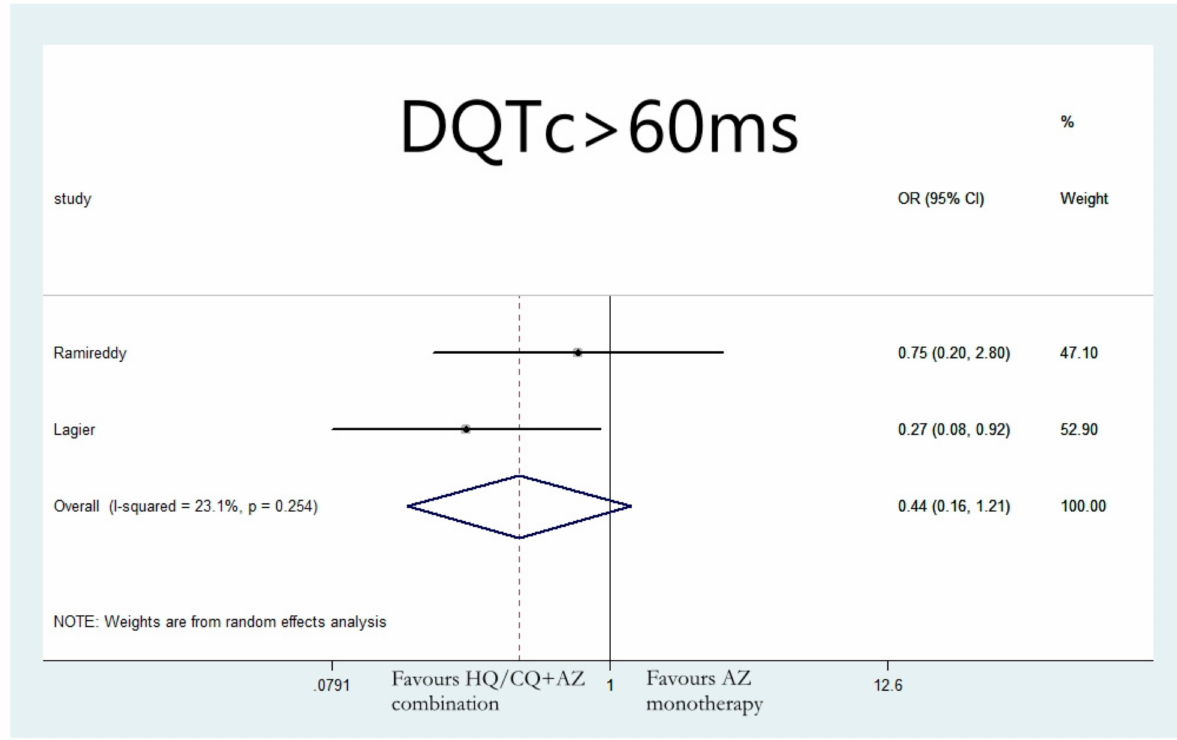
Figure 7. Risk of developing ∆ QTc > 60 ms in patients that received combination therapy with hydroxychloroquine and azithromycin vs. azithromycin